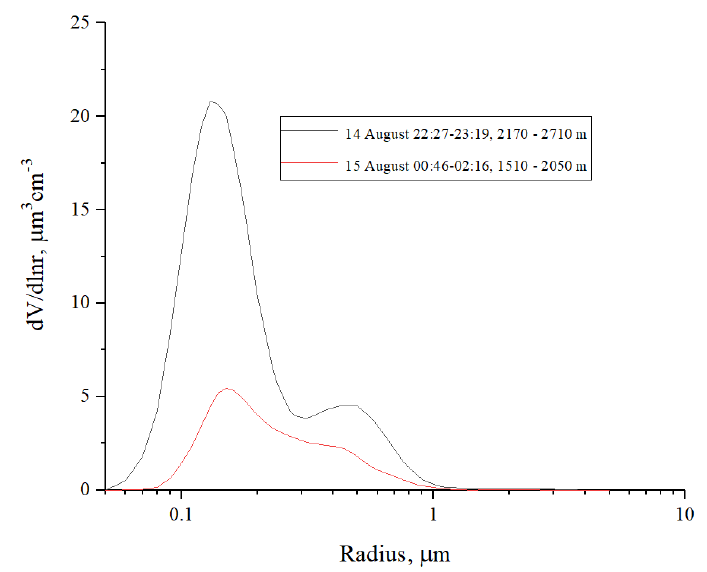
Figure 7. Volume size distribution retrieved starting from the lidar measurements of 14 August 2021 from 22:27 to 23:19 UTC and from 00:46 to 02:16 UTC. Table 2. Values from 22:37 to 23:19 and 00:46 to 02 – 16 of effective radius (Reff), number concentra- tion (N), surface concentration (S), volume concentration (V), real part (mR), and imaginary part of the refractive index (mI), and single scattering albedo (SSA) at 355, 532, and 1064.